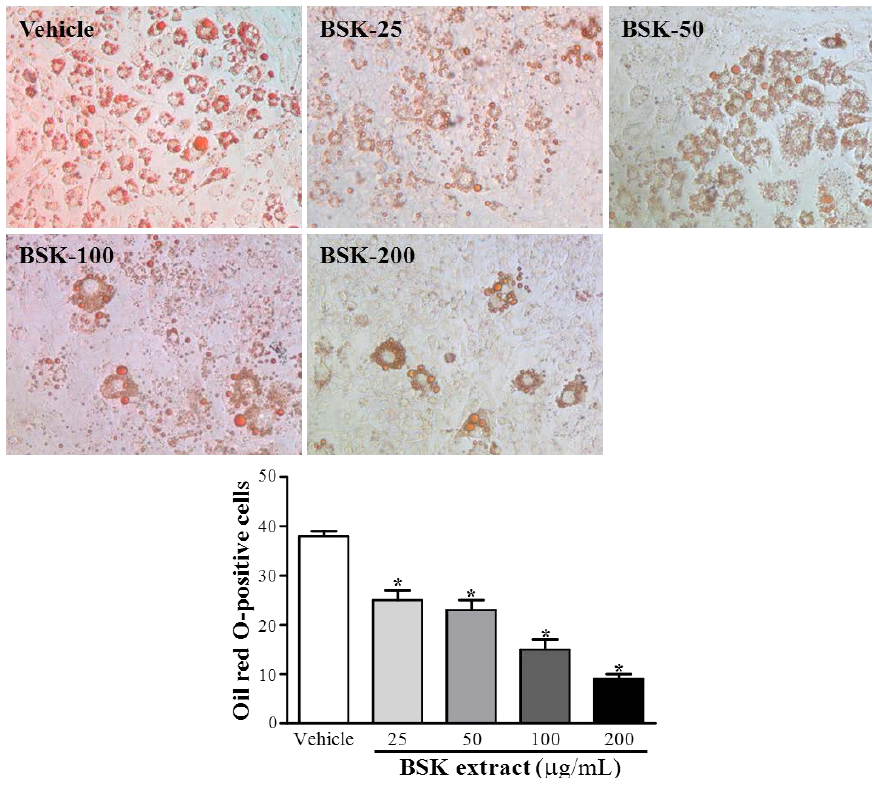
Figure 2. Effect of BSK extract on 3T3-L1 differentiated preadipocytes. During differentiation, cells were treated with vehicle (0.1% DMSO) or with the indicated concentrations of BSK extracts at 25, 50, 100 and 200 µg/mL, which were respectively designated the BSK-25, BSK-50, BSK-100 and BSK-200 groups. On day 8, cells underwent Oil-red O staining. Oil red O-positive cells calculated by the number of positive (red) cells. Data are mean ± SEM of 3 independent experiments. * p < 0.05 compared with